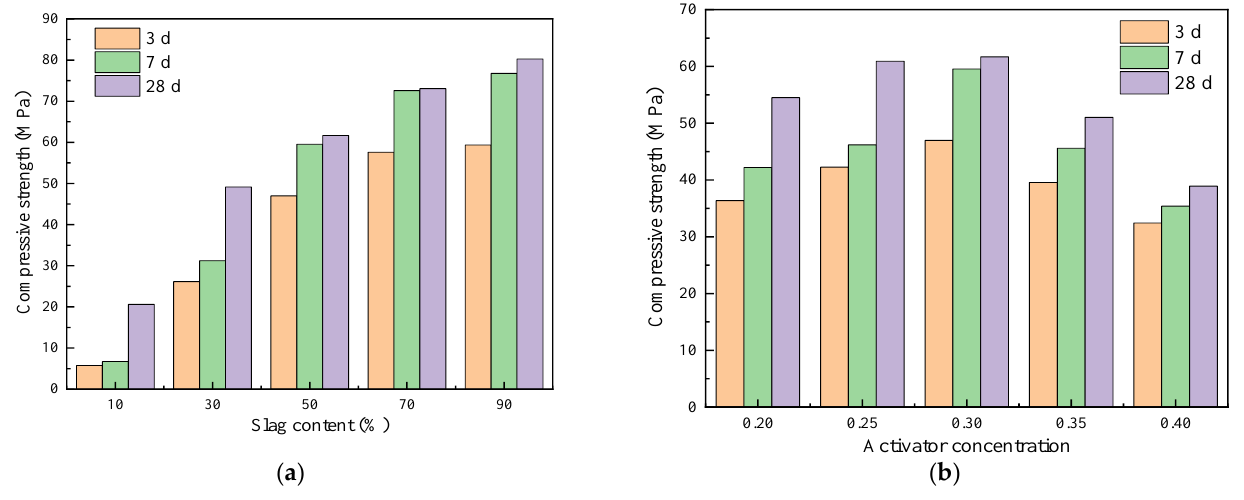
Figure 2. ( a ) The relationship between compressive strength and slag content at different ages; ( b ) the relationship between compressive strength and the activator concentration at different ages.